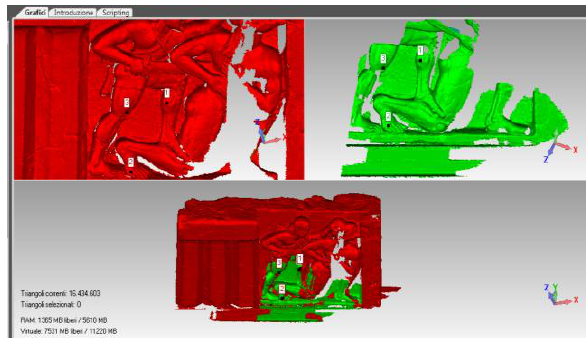
Figure 12. Manual registration in Geomagic Studio